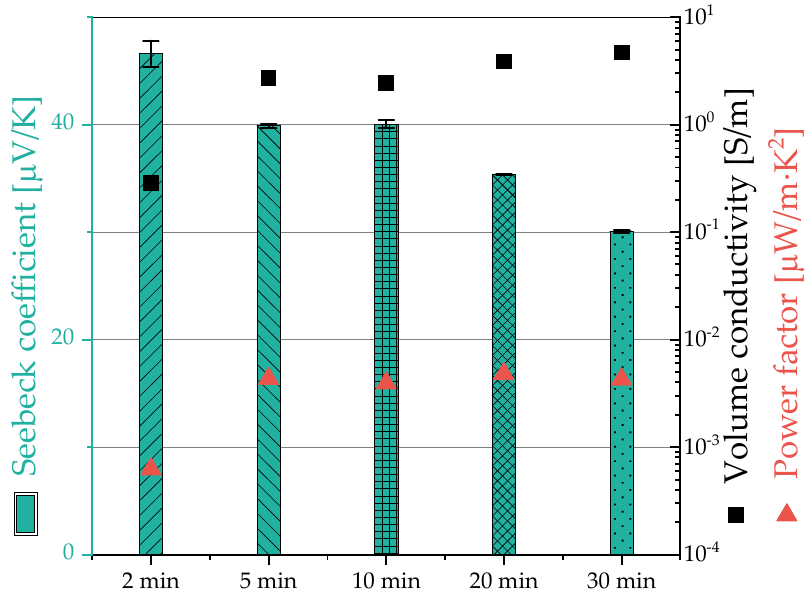
Figure 10. Seebeck coefficient, volume conductivity and power factor of PP/1 wt.% SWCNT composites at 40 °C, compression molding at different pressing times. Table 5. Thermoelectric parameters of the composites at 40 °C compression molded using different pressing times shown in Figure 10.